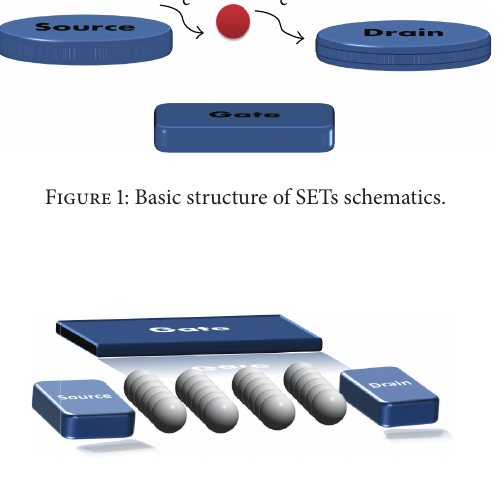
Figure 2: The 4 × 6 regular multi-islands systems. Each island is controlled electrostatically by the gate and is separated from its neighbor by a tunnel junction.